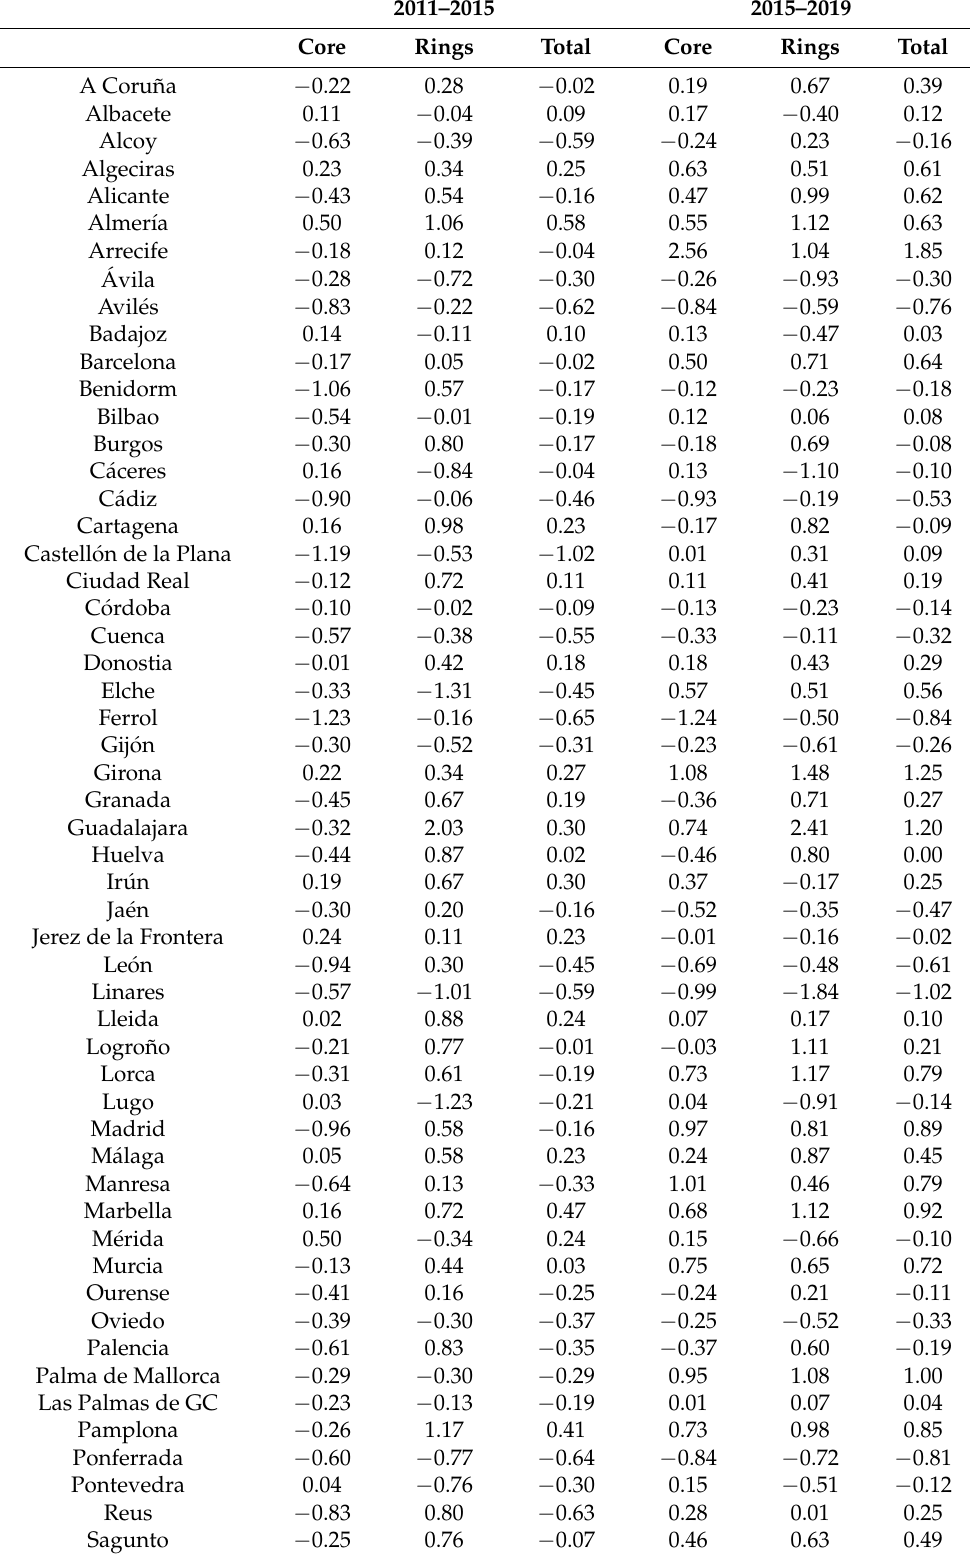
Table A1. Core and ring CAGRs for the analyzed FUAs in Spain in 2011–2015 and